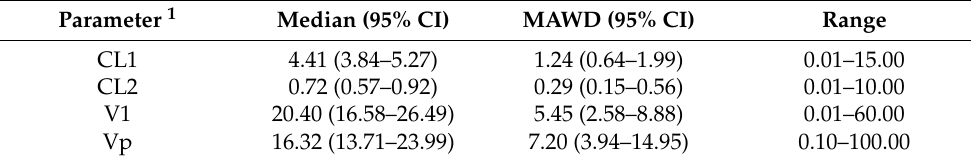
Figure 1. Structural model. V: central compartment volume; Q: intercompartmental clearance; Vp: peripheral compartment volume; CL: central compartment clearance; V1, CL1, and CL2: parame- ters; TBW: total body weight; eGFR: estimated glomerular filtration rate. Table 2. Population parameter estimates.